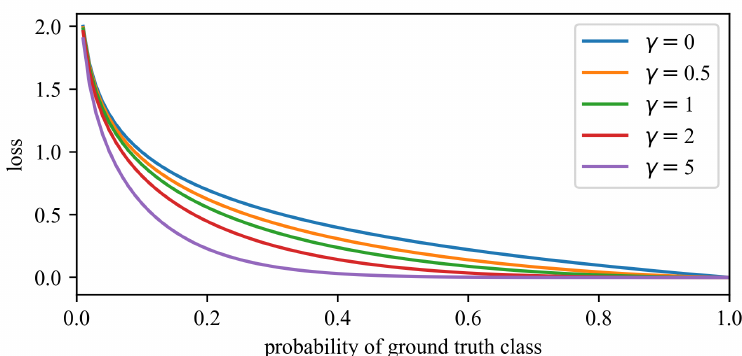
Figure 2. The loss curves of cross-entropy loss and focal loss with different γ values. Note that when γ = 0, the focal loss is identical to cross-entropy